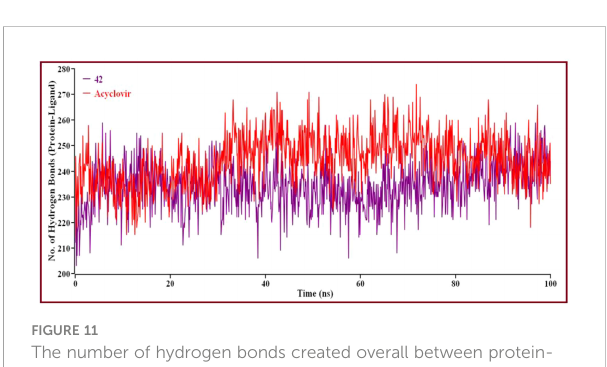
FIGURE 11 The number of hydrogen bonds created overall between protein- ligand complexes via MD simulations. Here, the red line indicates Acyclovir complexes, and violet lines indicate compound 42 complexes,